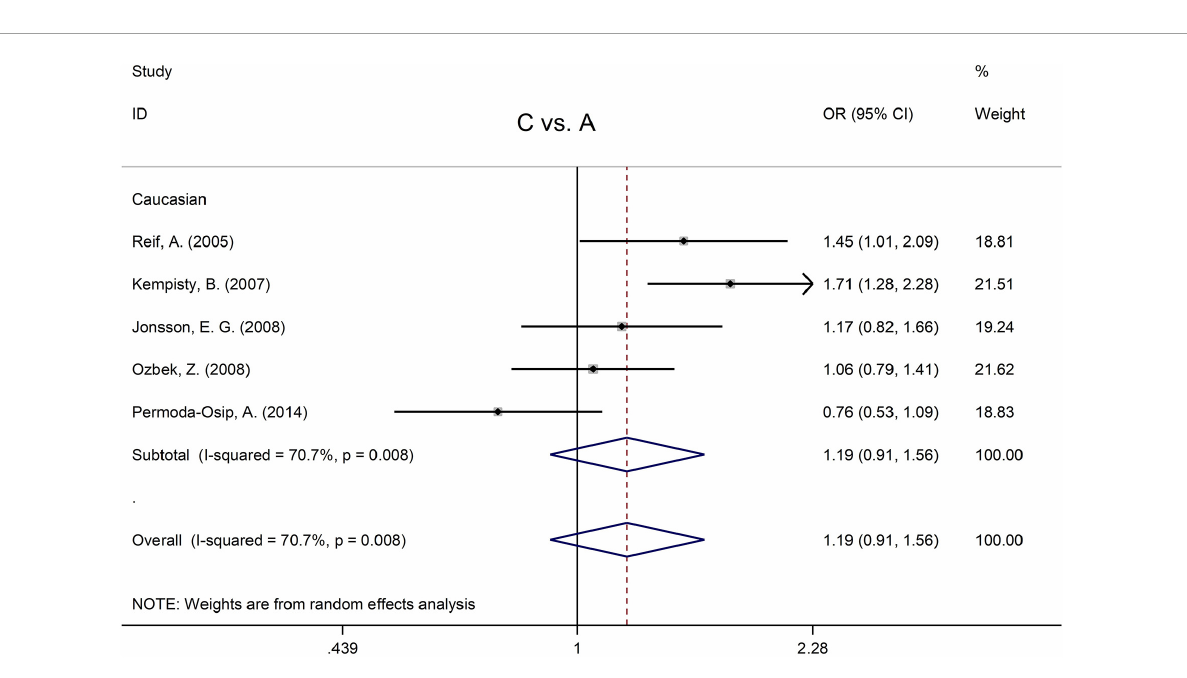
FIGURE7 Forest plots for the associations between MTHFR A1298C polymorphisms and BPD for the allele model with random effect